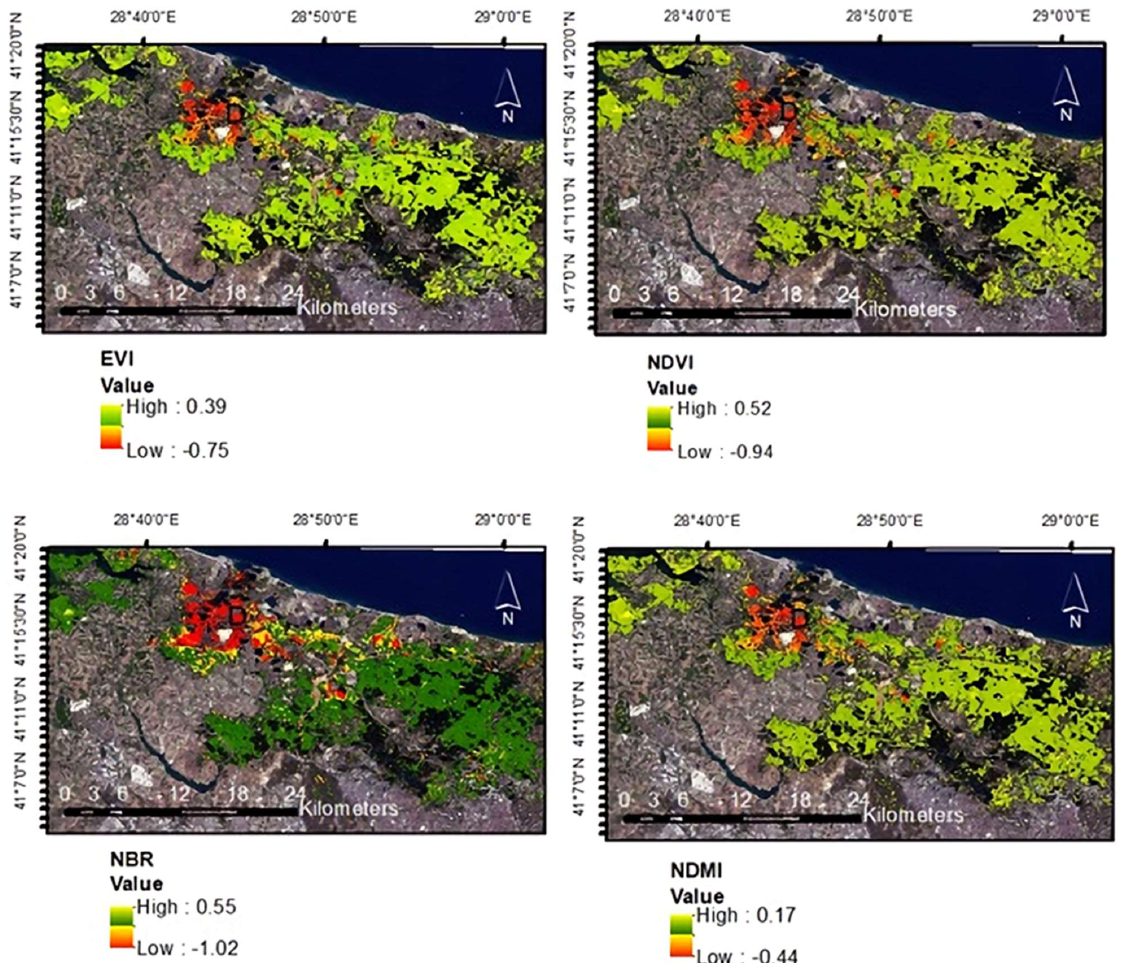
Figure 3. Magnitude values for all detected breakpoints in study area A according to threshold of − 0.05.